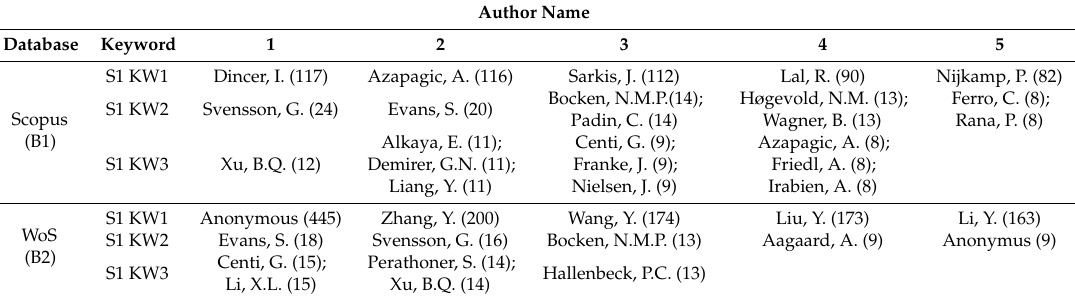
Table 4. Number of published scientific papers according to author names (TOP